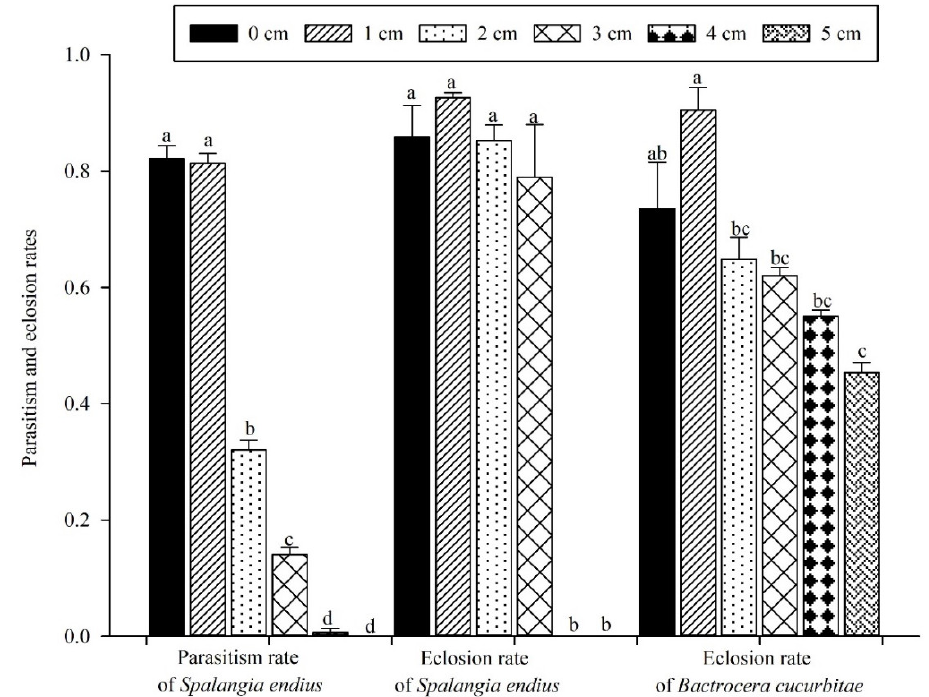
Figure 1. Effects of different soil depths on the parasitism and eclosion rates of Spalangia endius against Bactrocera cucurbitae and the eclosion rate of the host pupae. Means followed by the different lowercase (columns) in each bar are significantly different according to Tukey’s HSD multiple range test ( p < 0.05).